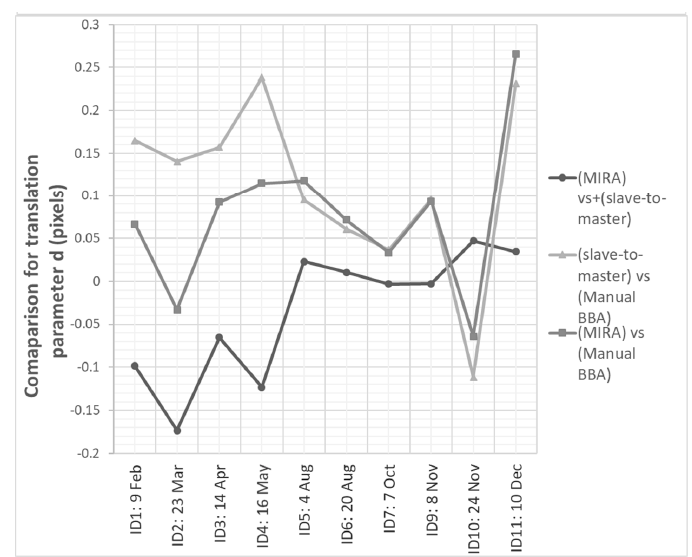
Figure 10. Comparison between the estimated parameters for all the images of ‘Multan’ dataset (band TM3) obtained by using MIRA and other methods: ‘slave-to-master’ (see Section 3.2.1) and ‘Manual BBA’ (see Section 3.2.2). For parameters c and d (shifts) the pairwise differences are shown. Inner and outer reliabilities have been computed for all three processing methods based on MIRA and manual observations. Values are reported in Table 8, where the results based on automatically extracted TPs have been also recomputed using the same precision of ‘manual’ measurements, which is supposed to be ±1 pixel. This solution has allowed to normalize the results and to make them comparable, since the TP precision had a linear scaling effect. In fact, the theoretical